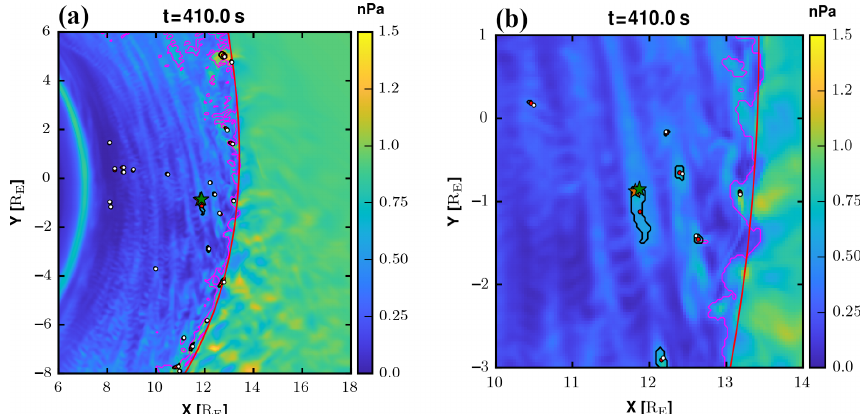
Figure 1. (a) A zoomed-in view of the magnetosheath in Vlasiator run LM30 at time 410s from the start of the simulation. The colour code shows the dynamic pressure in units of nanopascal (nPa). The magenta contour shows as a reference the regions where the Plaschke et al. (2013) criterion is at force using the 25% threshold. The black contours indicate jets identified with the Archer and Horbury (2013) criterion. The red line is an approximate fit of the bow shock location. Red dots indicate the average centre position of the jet, while the white dots show the location of largest velocity. The star refers to the location at which the virtual satellite and MMS data are taken and shown in Fig. 2. (b) Same as (a) but zoomed in further to show the jets in more detail. The two star positions indicate where data are shown in Fig. 2 (orange for Vlasiator and green for